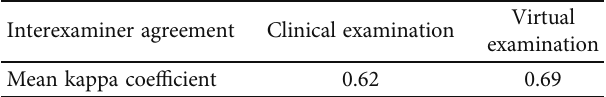
Table 1: Mean kappa coe ffi cient for interexaminer agreement in clinical and virtual examinations ( n = 480